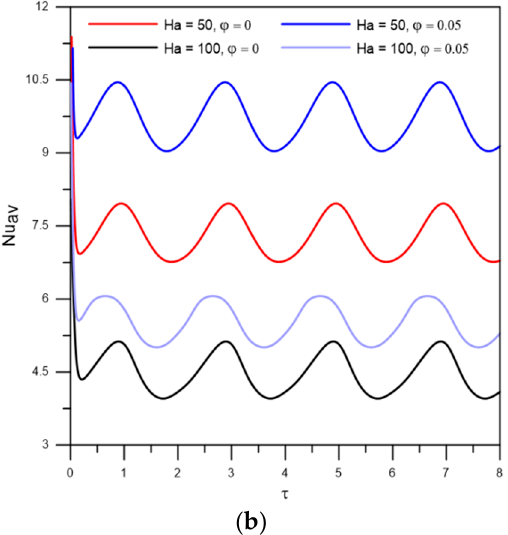
Figure 7. Variation of Nu av with ( a ) numerous f values at φ = 0.05, Ra = 10 6 , Ha = 100, A/L = 0.1; ( b ) τ at A/L = 0.1, f = 0.25 and Ra = 10 6 .